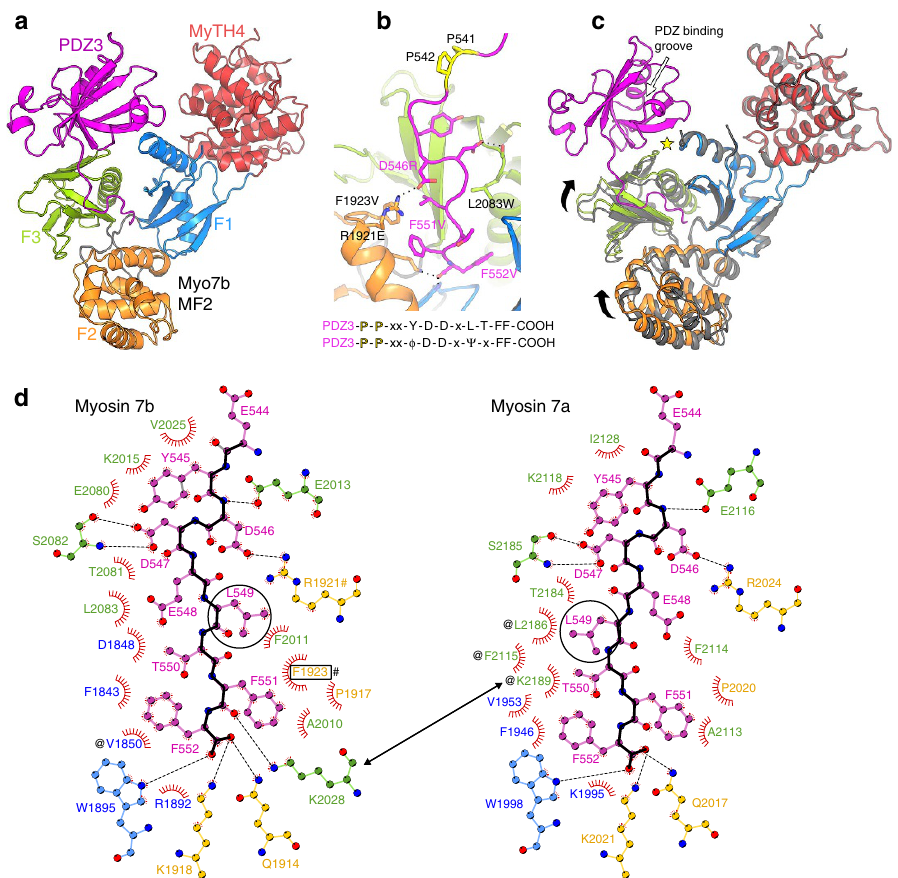
Figure 2 | Structural basis of harmonin PDZ3c recognition by Myo7b MF2. ( a ) Structure of the harmonin PDZ3c-Myo7b MF2 complex. The MyTH4 domain is shown in red and the FERM subdomains are coloured in blue (F1), orange (F2) and green (F3) throughout the figures. The harmonin PDZ3c is shown in magenta. ( b ) Critical residues mediating interactions between the harmonin Cter extension (magenta) and the Myo7b FERM (ribbon representation) domain. Important side chains are shown in sticks. Two conserved prolines (P541 and P542) at the end of the PDZ3 domain help direct the Cter extension. The motif that mediates binding to the FERM domain is shown (bottom). ( c ) Superimposition of the free (dark grey) and PDZ3c-bound (multi-coloured) Myo7b MF2 structures using the F1 lobe as a reference. The black arrows indicate the lobe displacements upon PDZ3c binding. The white arrow in the PDZ3 domain indicates the partner-binding groove within the PDZ3 domain. The yellow star highlights the interface between the PDZ3 domain and the Myo7b F1 and F3 lobes. The minor changes in the orientation of the three lobes ( o 5 (cid:2) ) promote optimal interactions between the Cter peptide and the FERM domain via an induced fit of small amplitude. ( d ) Diagram of the interactions between the harmonin PDZ3 Cter extension (magenta, black backbone) and the Myo7 FERM domain. Dotted lines: hydrogen bond within distances o 3.5Å; Red spikes: hydrophobic interactions. The major difference between the two complexes is in the orientation of harmonin L549 side chain (black circles) due to the F1923 Myo7b (black box)/Y2026 Myo7a substitution. The following residue, T550, also changes its environment (# denotes residues interacting with L549, while @ indicates residues interacting with T550). The black arrow indicates the homologous lysines 2086/2189 (Myo7b/Myo7a) that interact differently with PDZ3c. This figure is generated using LigPlot þ 69